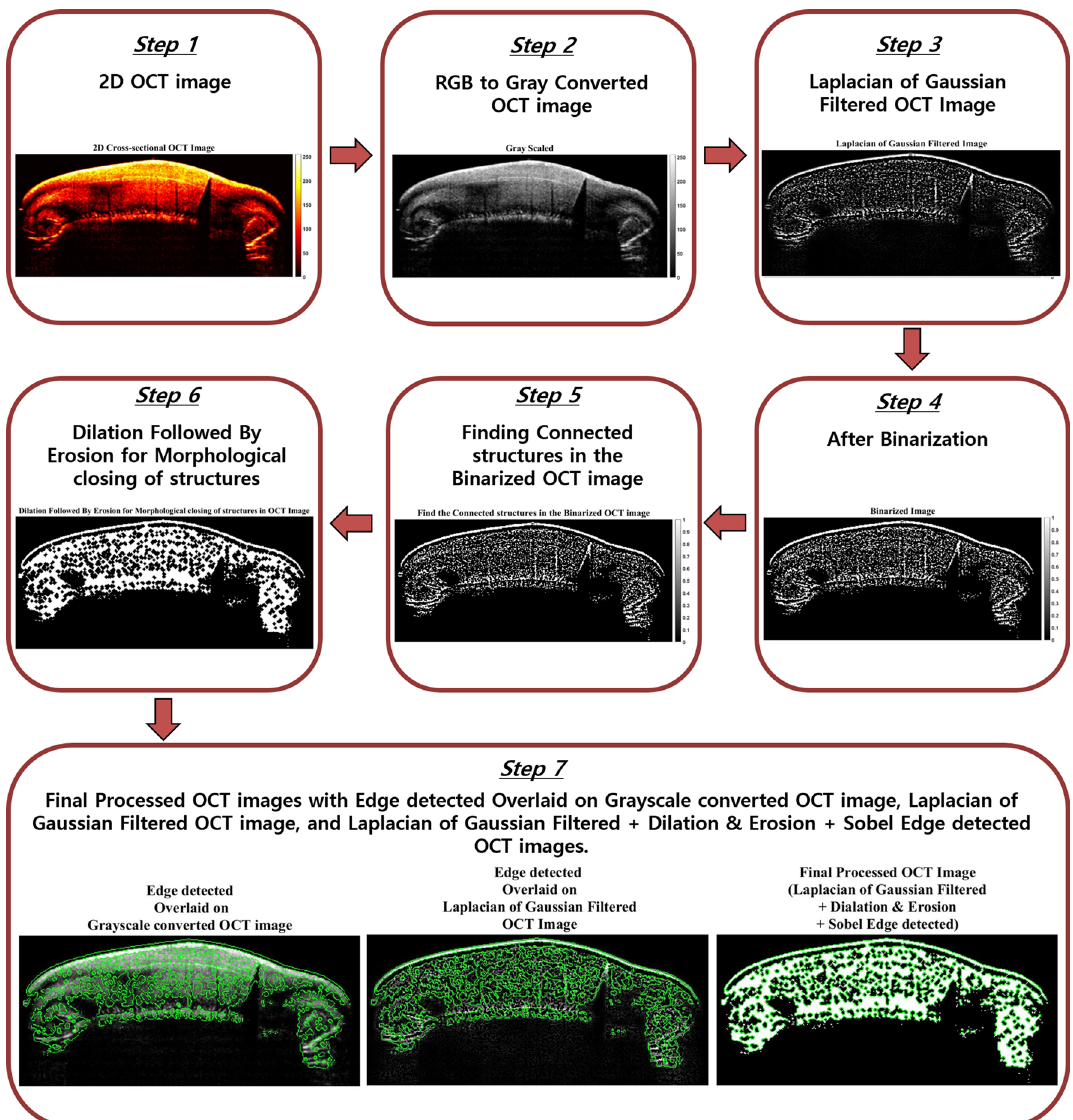
Figure 3. Stepwise representation of the algorithm for analyzing enamel loss and abrasion from an OCT